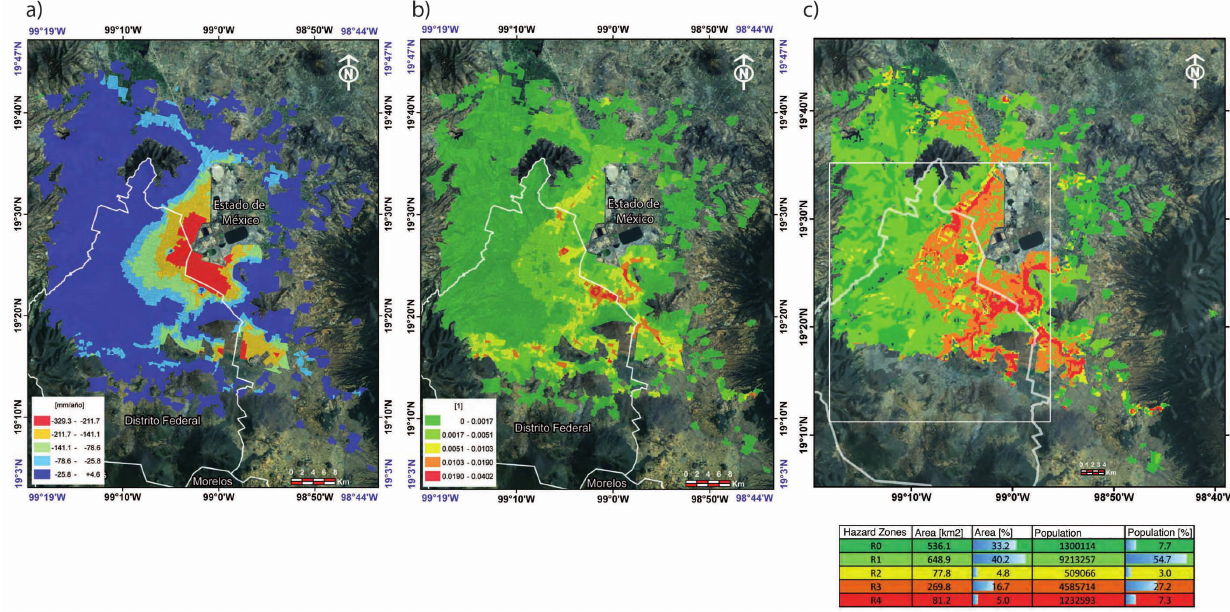
Figure 4. Example of hazard zonation for surface faulting associated to ground subsidence in the Mexico City Metropolitan Area. Left panel: ground subsidence magnitude. Central panel: subsidence horizontal gradient zonation. Right panel: hazard zonation. In this example, 21.7% (351.0km 2 ) of the city’s urban area and 34.5% of its population (4709305 inhabitants) are under a high to very high risk of being affected by faulting associated with subsidence (right